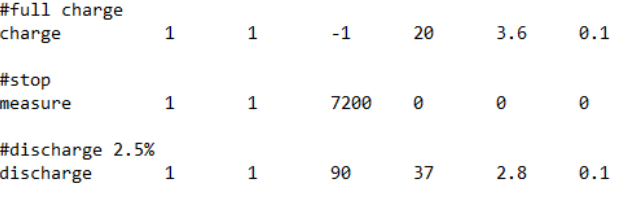
Figure 4. Example of Step-file syntax.